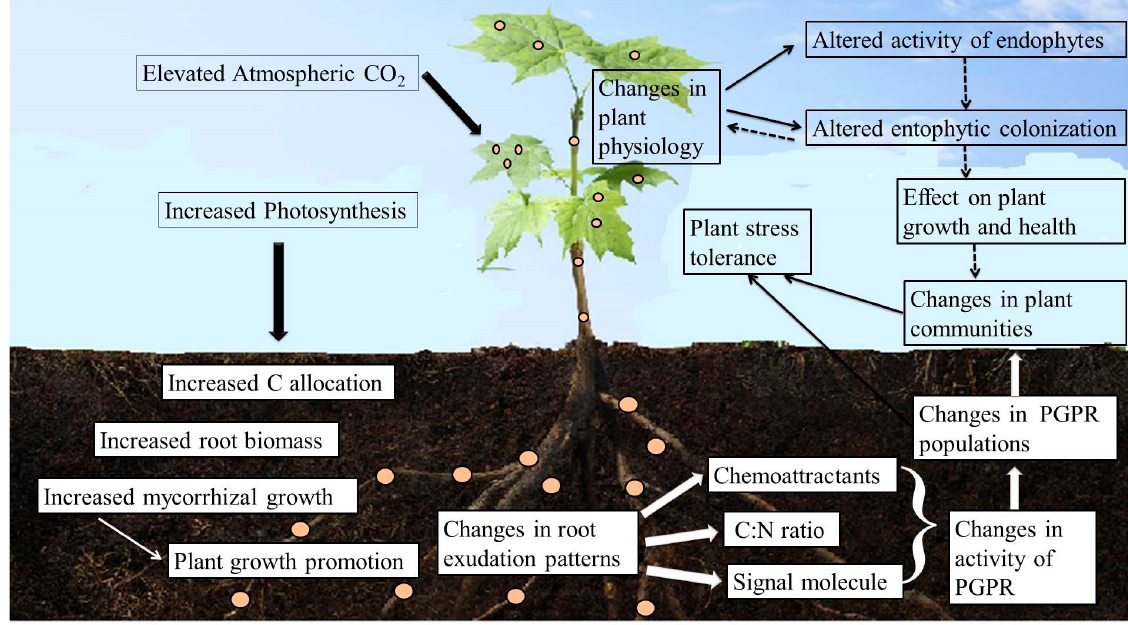
Figure 1. Effects of elevated CO 2 concentration on plants.